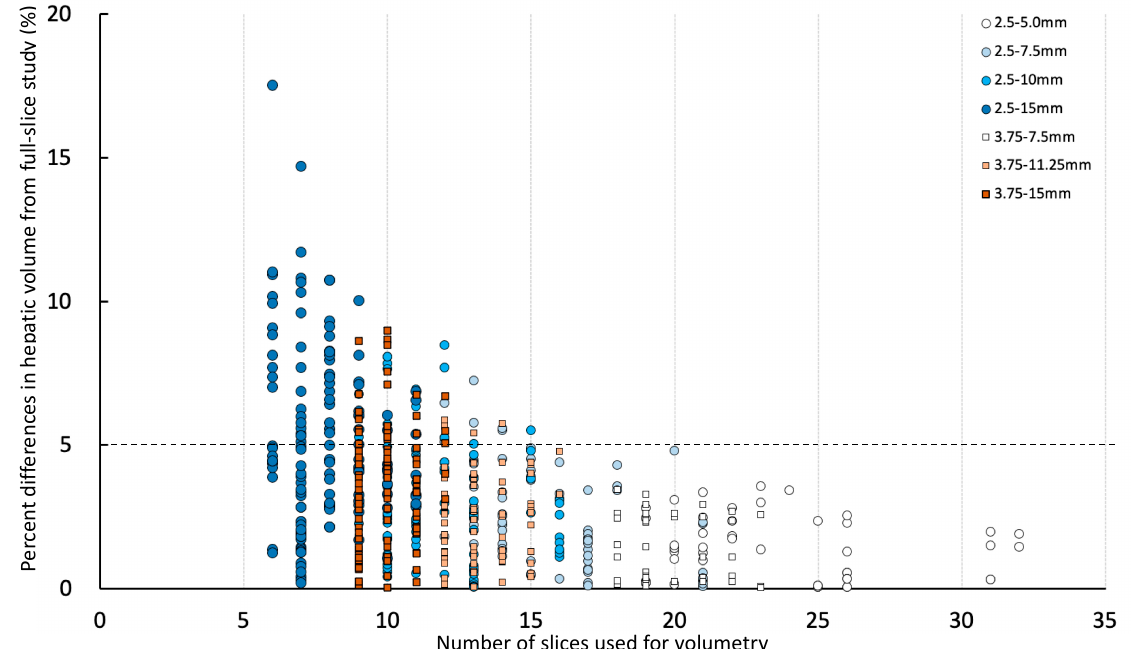
Figure 4. Percent differences in hepatic volume compared to 2.5-full or 3.75-full with numbers of slices used for hepatic volumetry. The percent difference lower than dotted line (less than 5%) is considered acceptable.